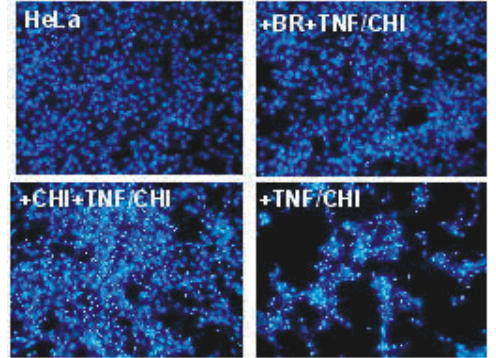
Fig. 2. The pretreatment for 3 hours of HeLa cells with brefeldin A (BR) or cycloheximide (CHI) increases their resistance to